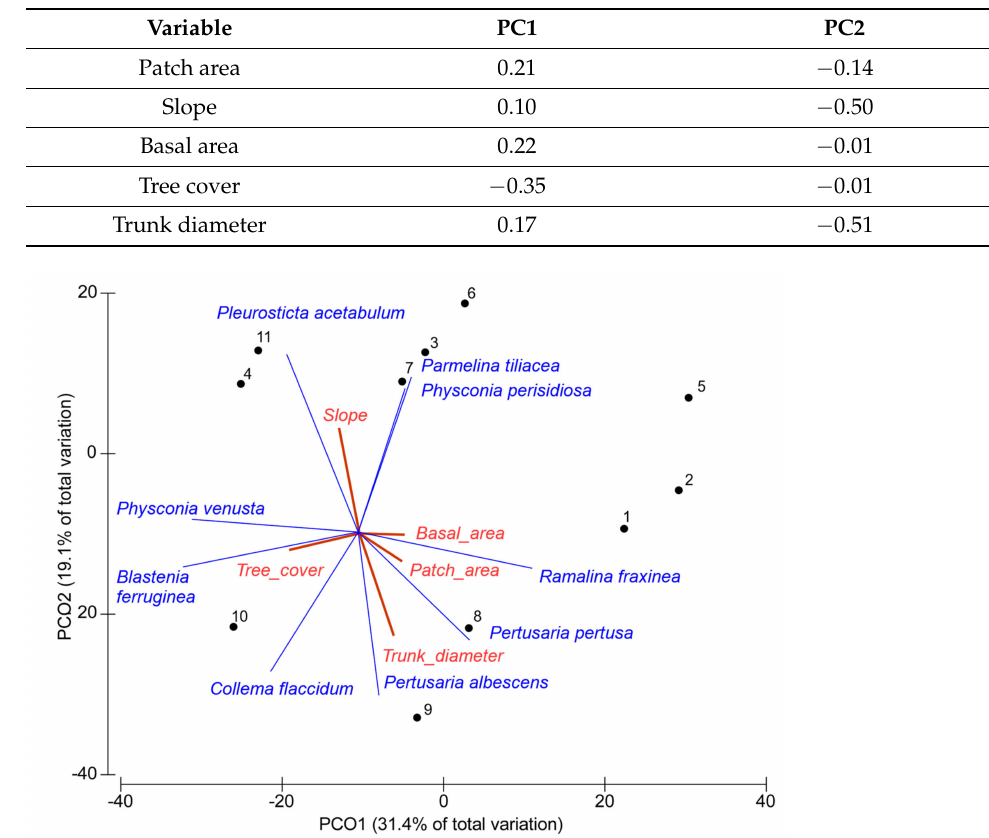
Figure 2. Linear model of lichen richness and patch_area relationship at plot level. The red solid line is the linear trend line; blue lines represent the 95% confidence intervals. Numbers of the plots are the same as in Table 1 and Figure 1. Table 3. Loadings of the most related variables (Spearman’s r > 0.3) with the two ordination axes of PCoA shown in Figure 3.